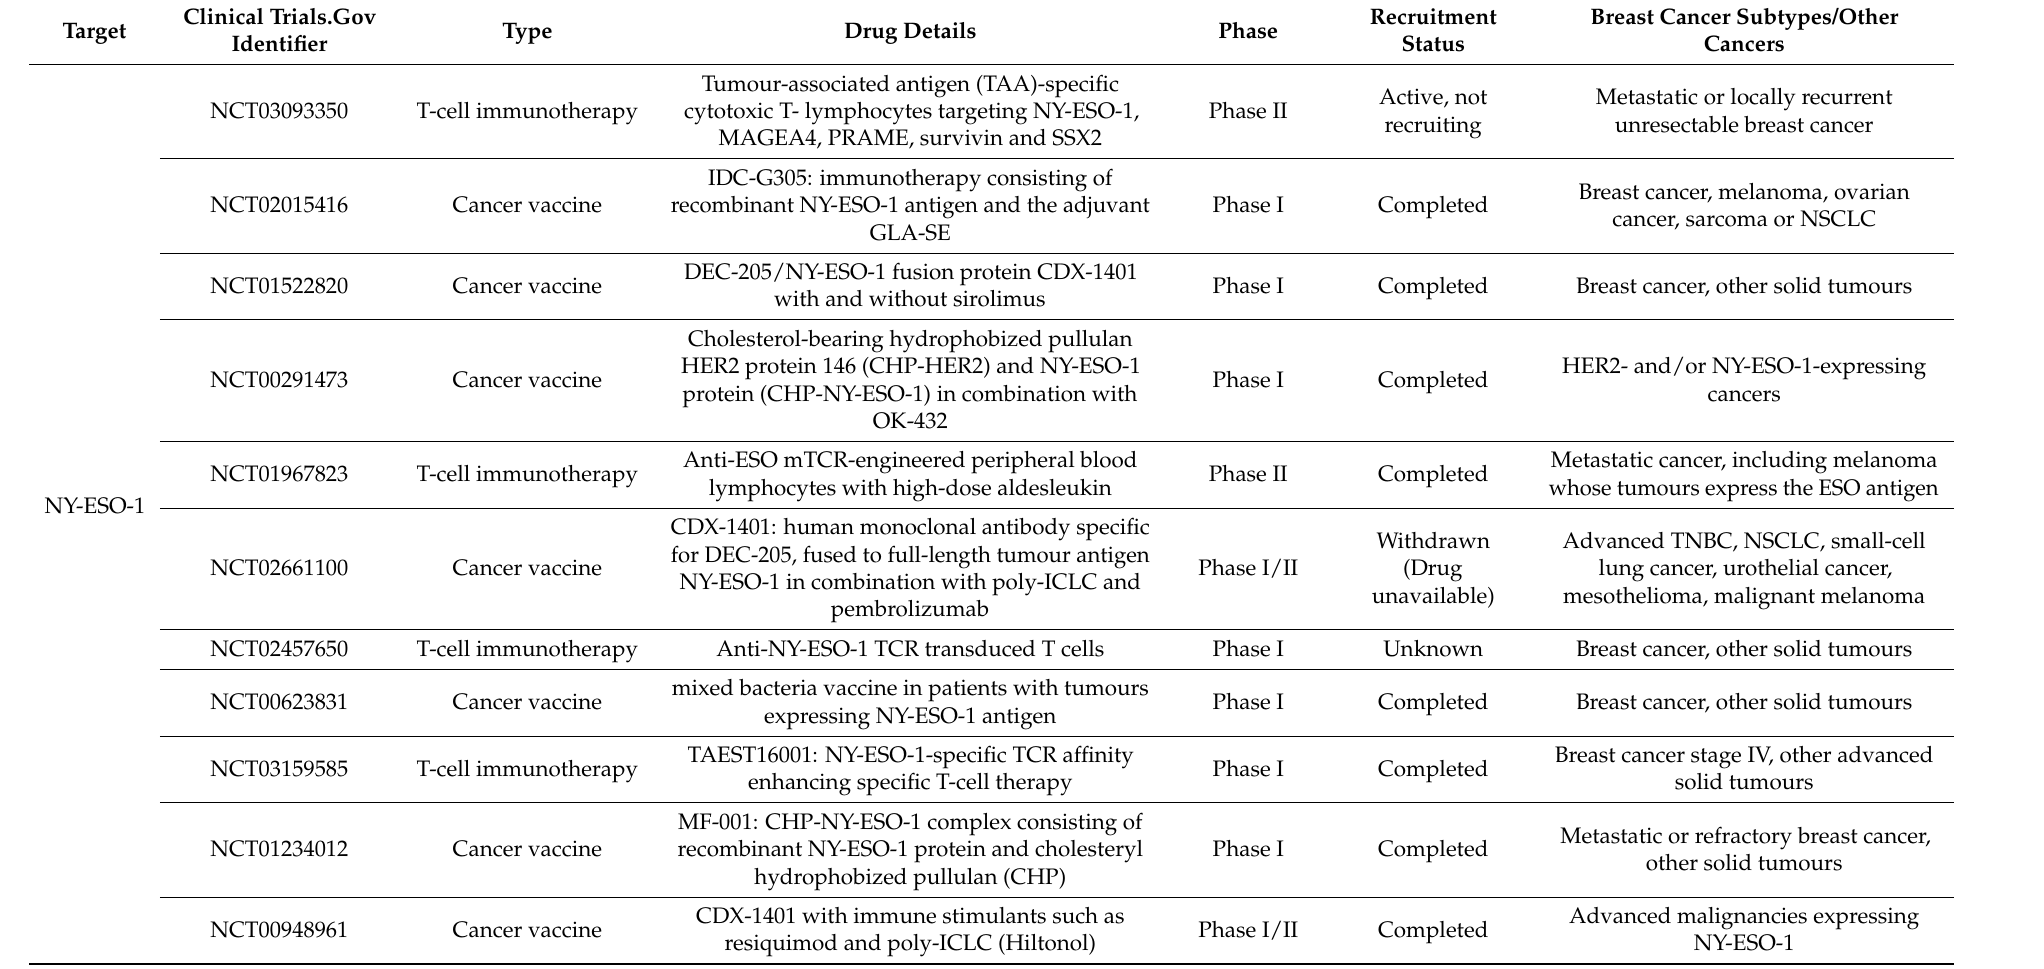
Table 2. Summary of clinical trials involving CTAs with a focus on breast